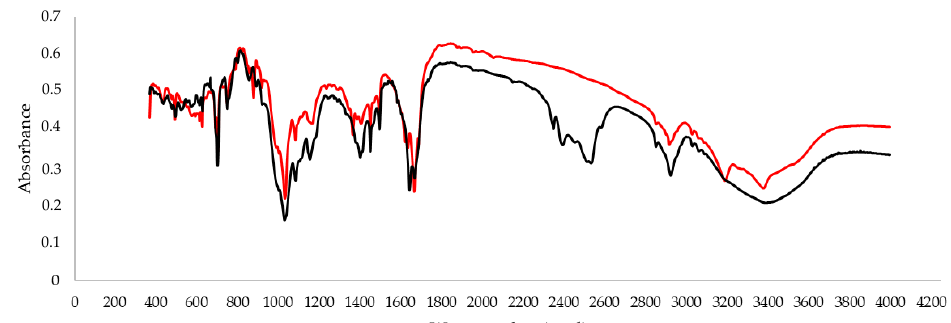
Figure 6. IR spectra of armodafinil (red line) and armodafinil-d 3 (black line) in KBr.